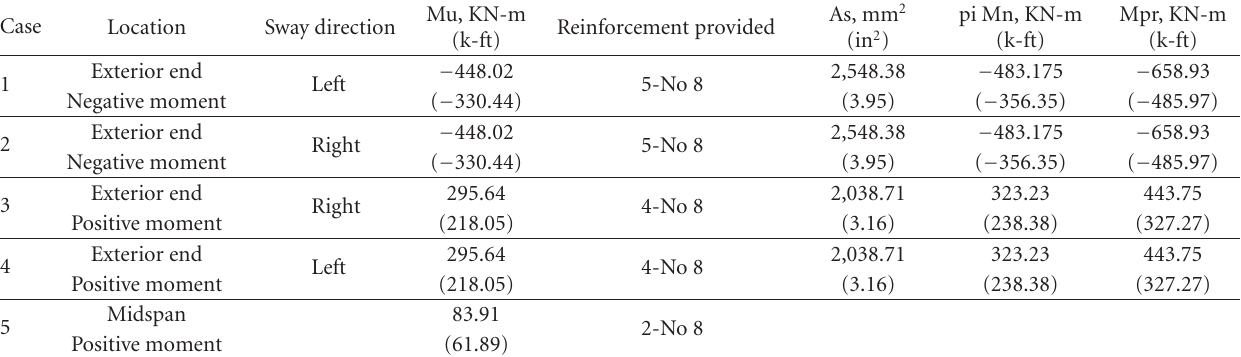
Table 2: Details of beam B2.